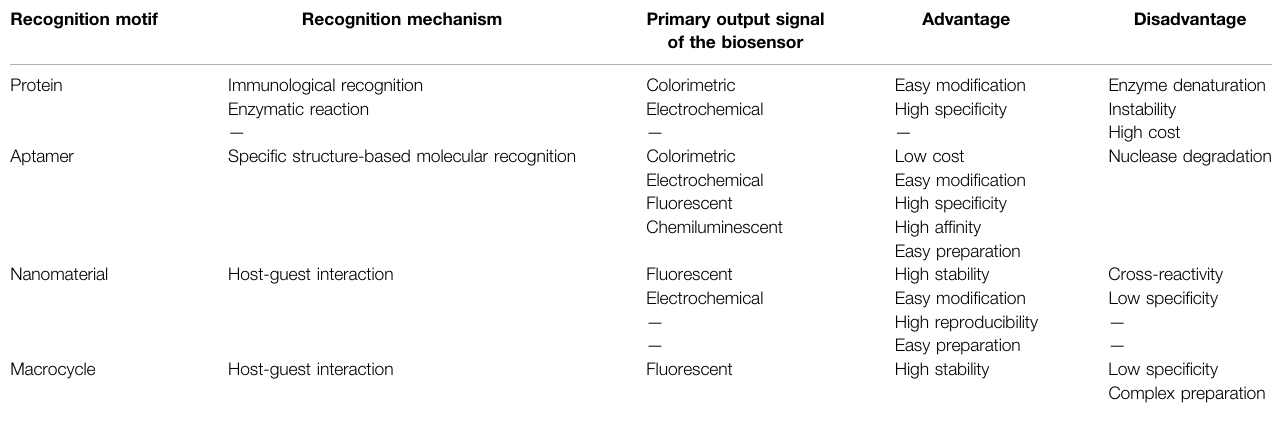
TABLE 1 | A comparison between different recognition motifs in the detection of pesticide residues. Recognition